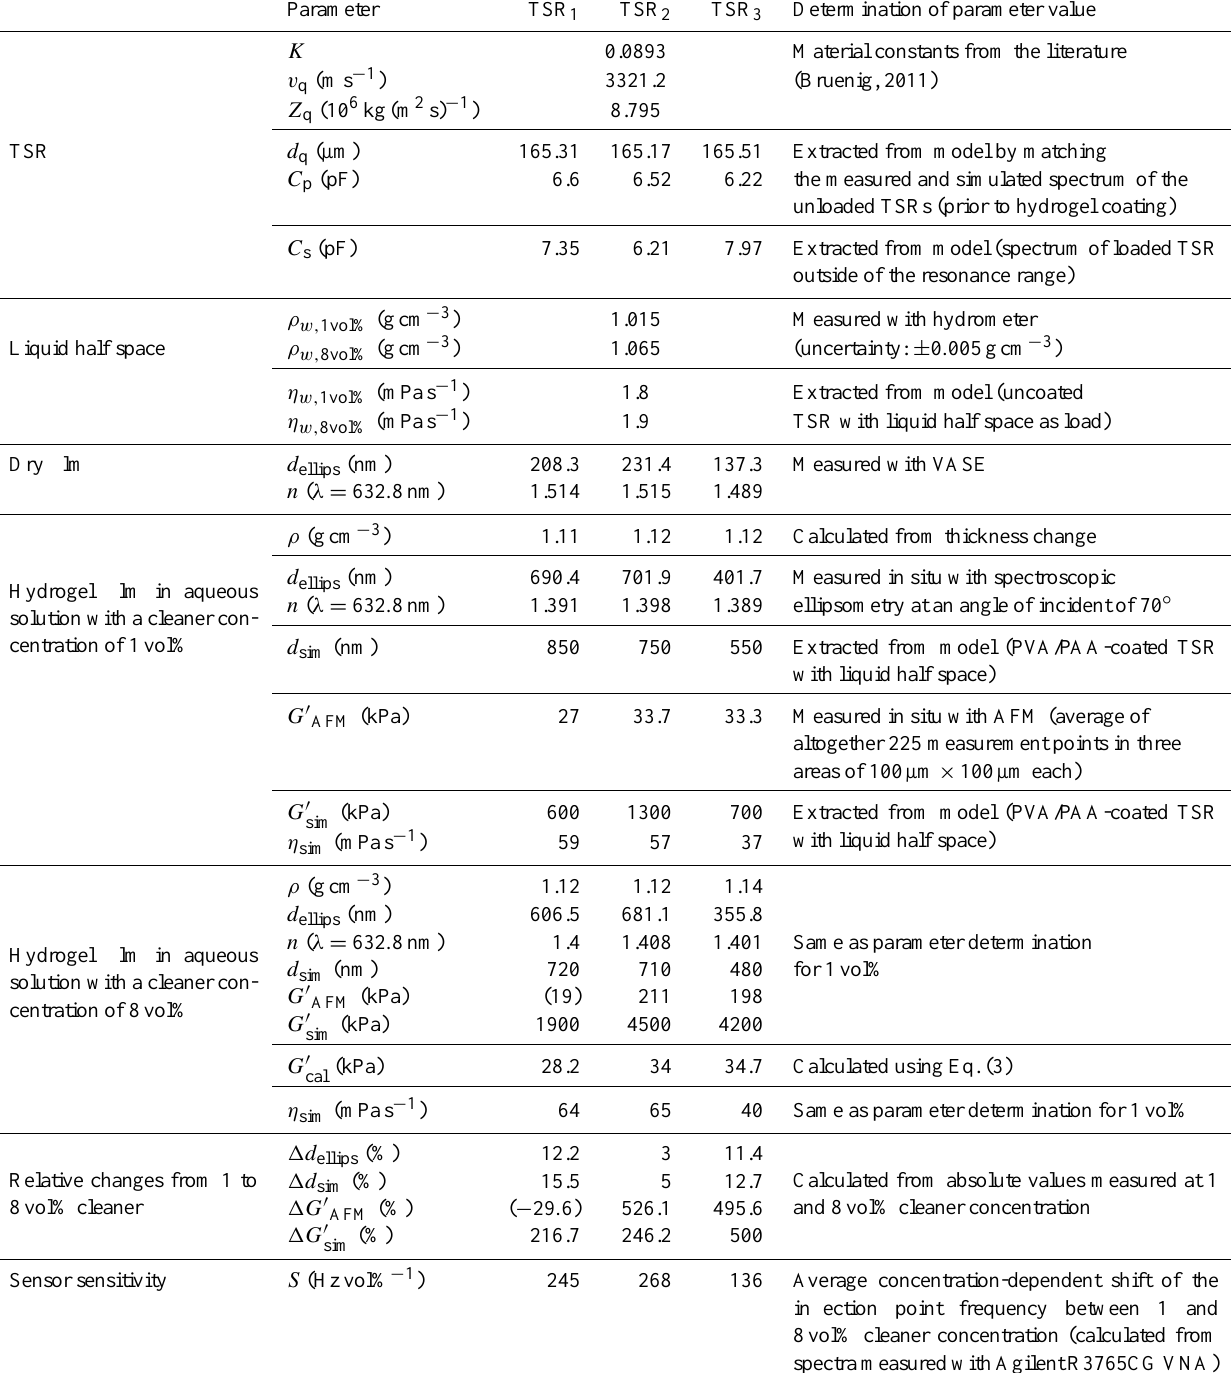
Table A3. Parameter determination of the model-based indirect measurement